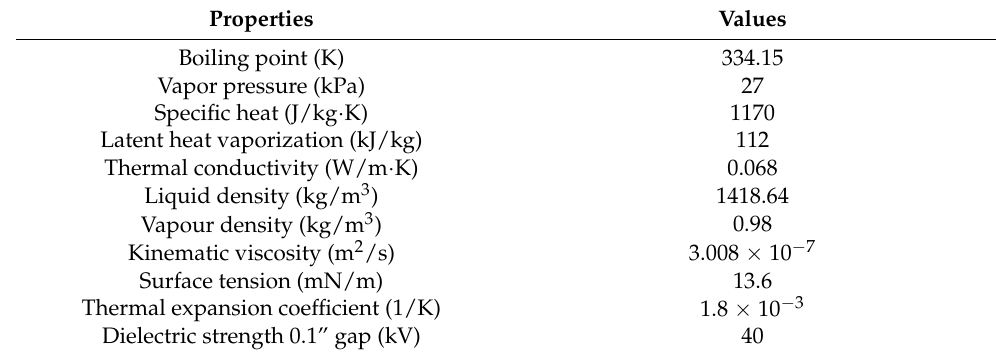
Table 2. Properties of HFE-7100 at saturation temperature